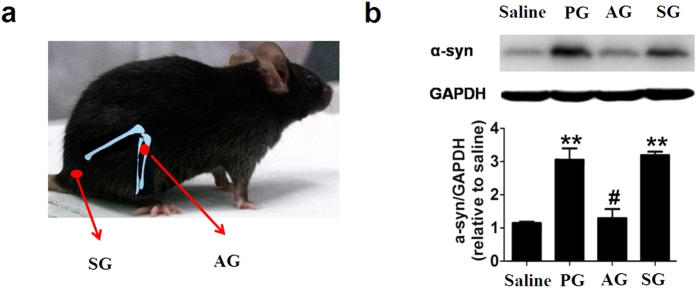
The acupoint position and α-synuclein expression.(a) AG: acupuncture at the acupoint of Yanglinquan (GB34); SG: sham acupuncture at the control point. (b) The expression of a-syn (top) and the optical density of α-syn (bottom) in the mouse SNpc in each group (7th day after last MPTP injection). In all panels, *P < 0.05, **P < 0.01 compared with Saline group. #P < 0.05, ##P < 0.01 compared with MPTP group. n = 8 per experimental group.